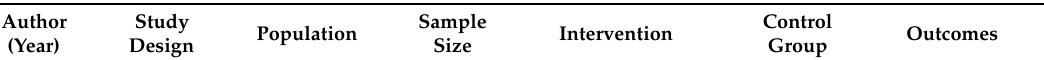
Table 1. Characteristics of the studies included in the systematic